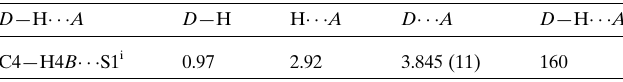
Table 2 Hydrogen-bond geometry (A˚ , (cid:3)